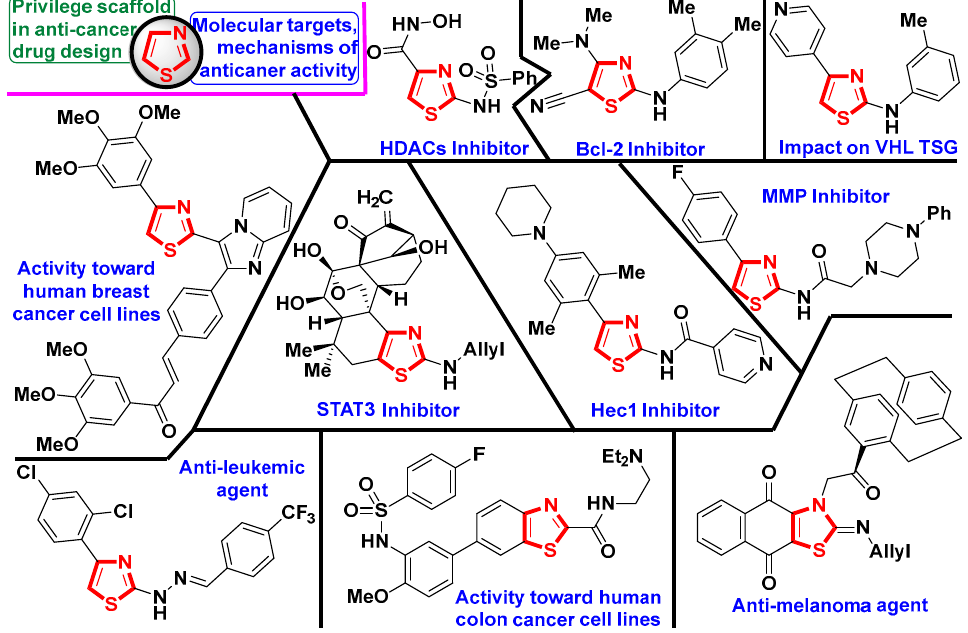
Figure 1. Thiazole-bearing molecules which possess anticancer